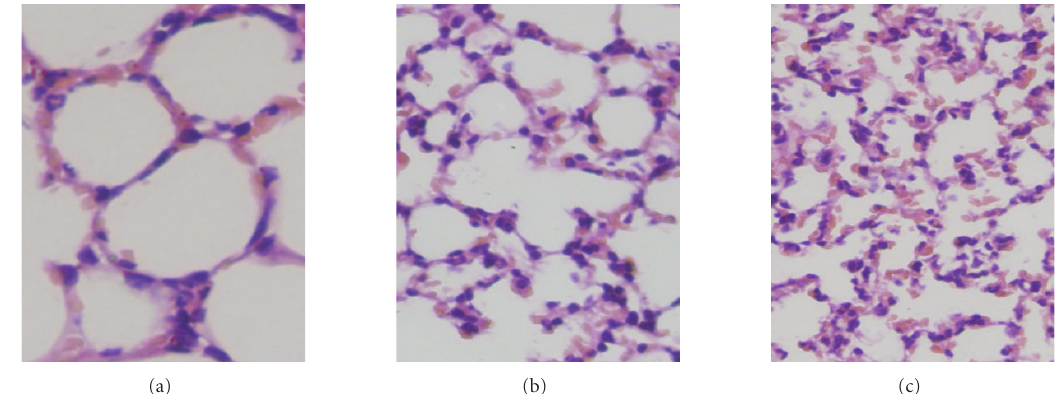
Figure 1: Histopathological examination. Three pictures of pathological sections showing (a) pathological appearance from control group, (b) pathological appearance from LPS group at 24 hours, and (c) pathological appearance from LPS group at 48 hours (HE ∗ 300).